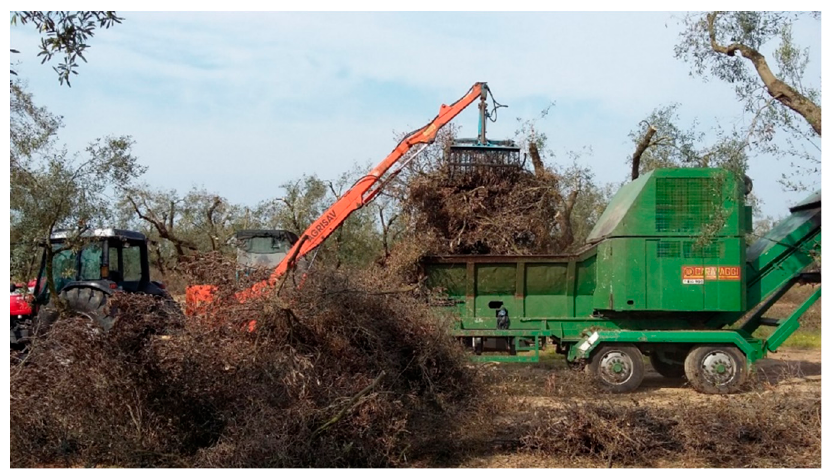
Figure 2. Stationary chipper Caravaggi and tractor with uploading equipment.